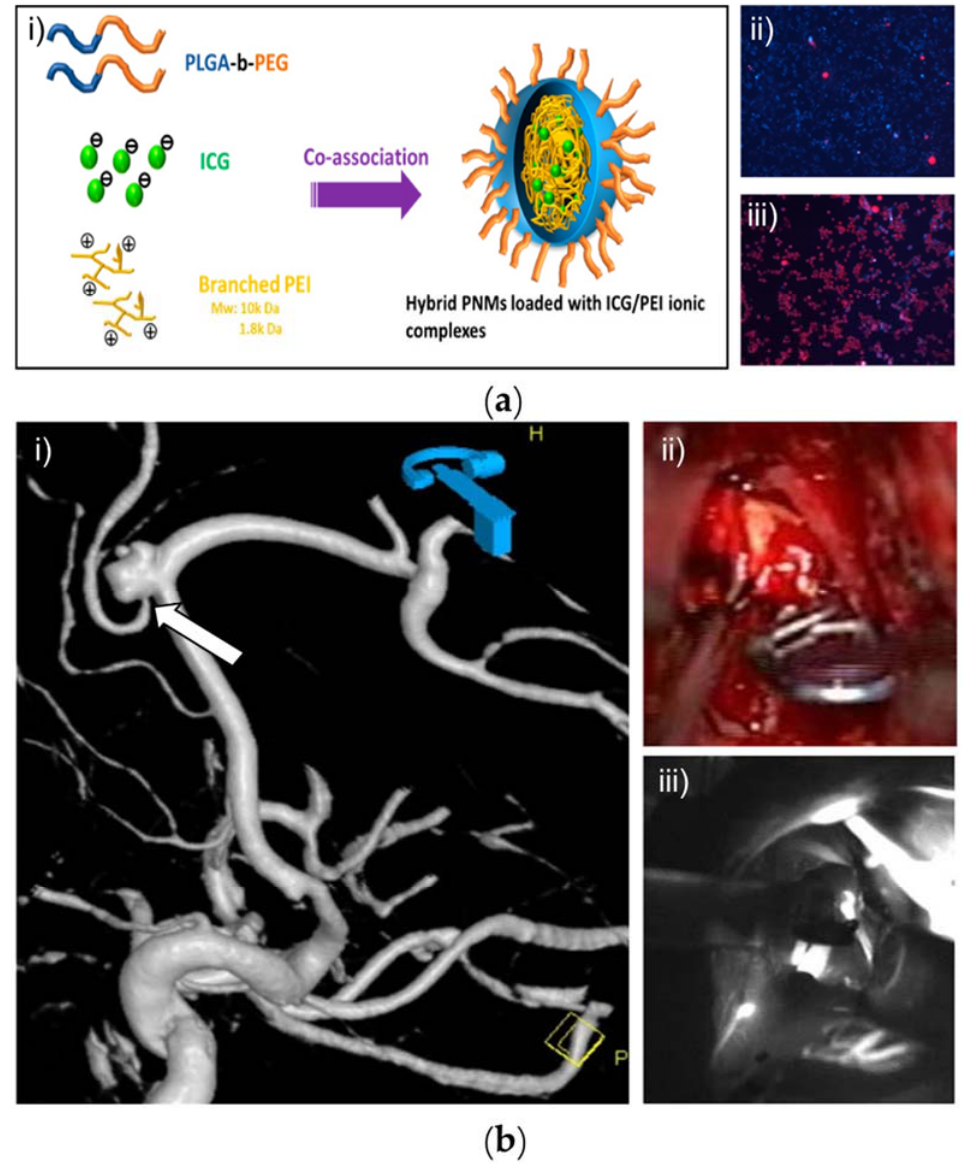
Figure 8. ICG-encapsulated nanoparticles for biomedical applications. ( a ) Function in PTT: ( i ) Schematic illustration showing the structure of ICG/PEI-encapsulated hybrid polymeric nanomicelles (PNMs); Fluorescence images of HeLa cells treated with free ICG (10 µ M) ( ii ) or ICG/PEI-loaded PNMs ( iii ) with laser irradiation. Reproduced from Ref. [91] , with permission from American Chemical Society, 2015. ( b ) Utilization of polymeric nanocomposites in microsurgery and angiography: ( i ) Complex aneurysm of the pericallosal artery as displayed by the 3D reconstruction of DSA; ( ii ) Patency of the branching artery was analyzed by the use of intraoperative micro-Doppler after aneurysm clipping; and ( iii ) NIR ICG video angiography (ICGVA). Both methods assumed good local blood flow through a small perforating artery during surgery, which was not seen in the intraoperative cranial CT angiography (iCTA). Reproduced from Ref. [145], with permission from Springer-Verlag, 2012.